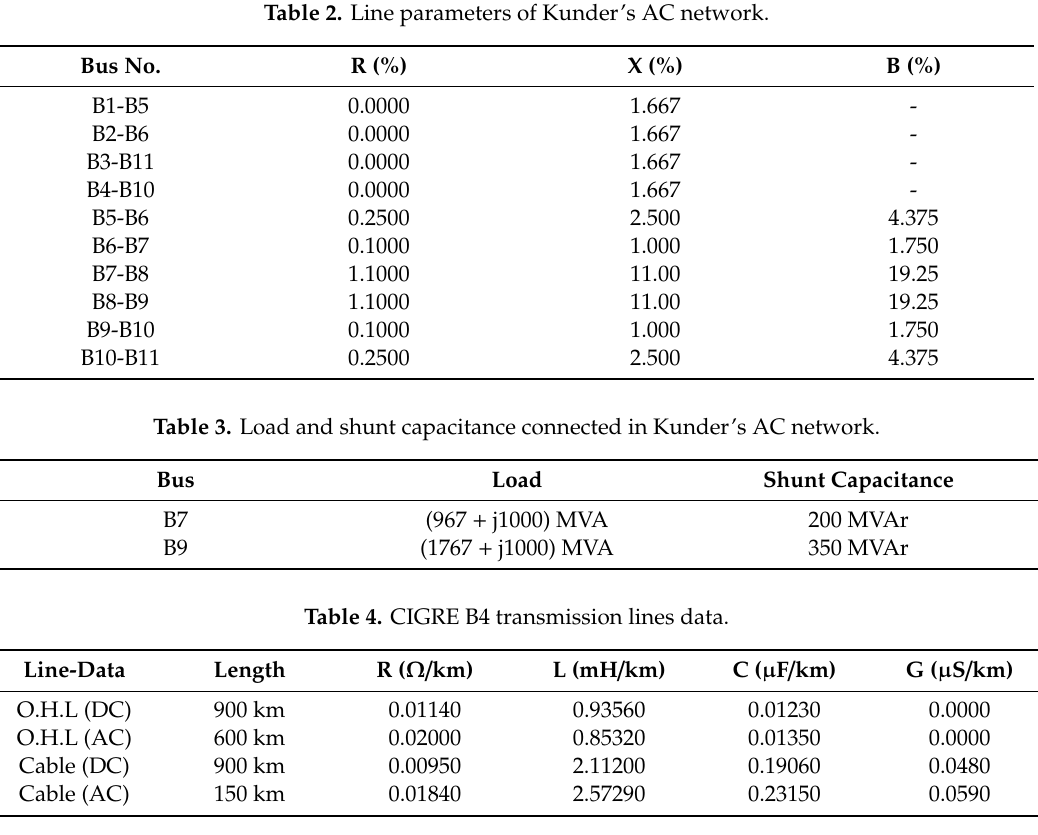
Table 5. VSC-HVDC stations